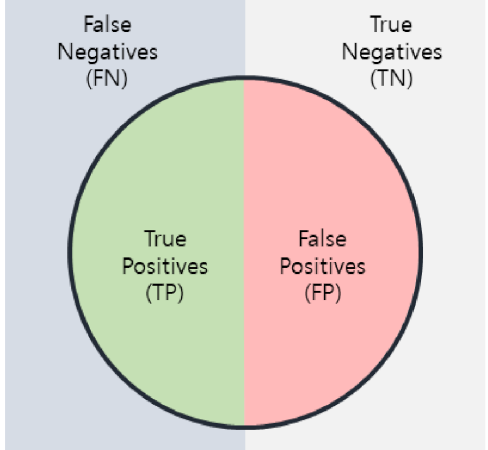
Figure 2. Performance evaluation index of the model. Accuracy is a representative indicator used and indicates the degree to which the value to be measured is correctly predicted, and is obtained by Equation (1).